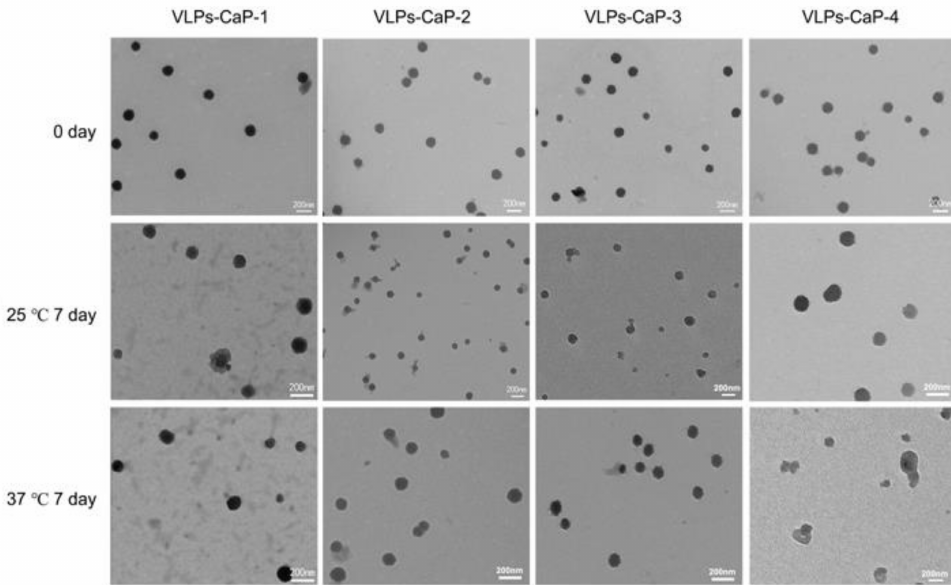
Figure 5. Long-term stability of the VLPs-CaP complexes. TEM images of CaP-VLPs-1, CaP-VLPs-2, CaP-VLPs-3, and CaP-VLPs-4 stored at different temperatures for different periods of time.